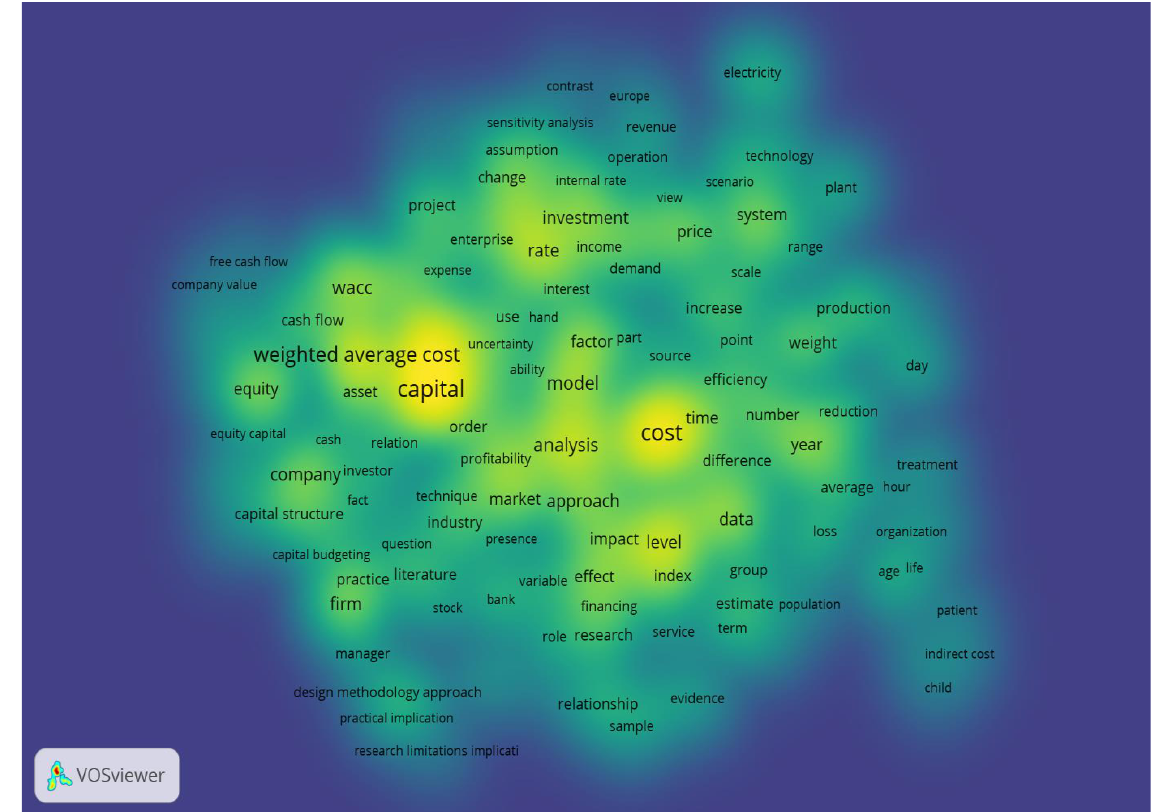
Figure 3. Most common words in the field. Source: Authors’ selection from the WoS database, based on selected words, using the VOS program.